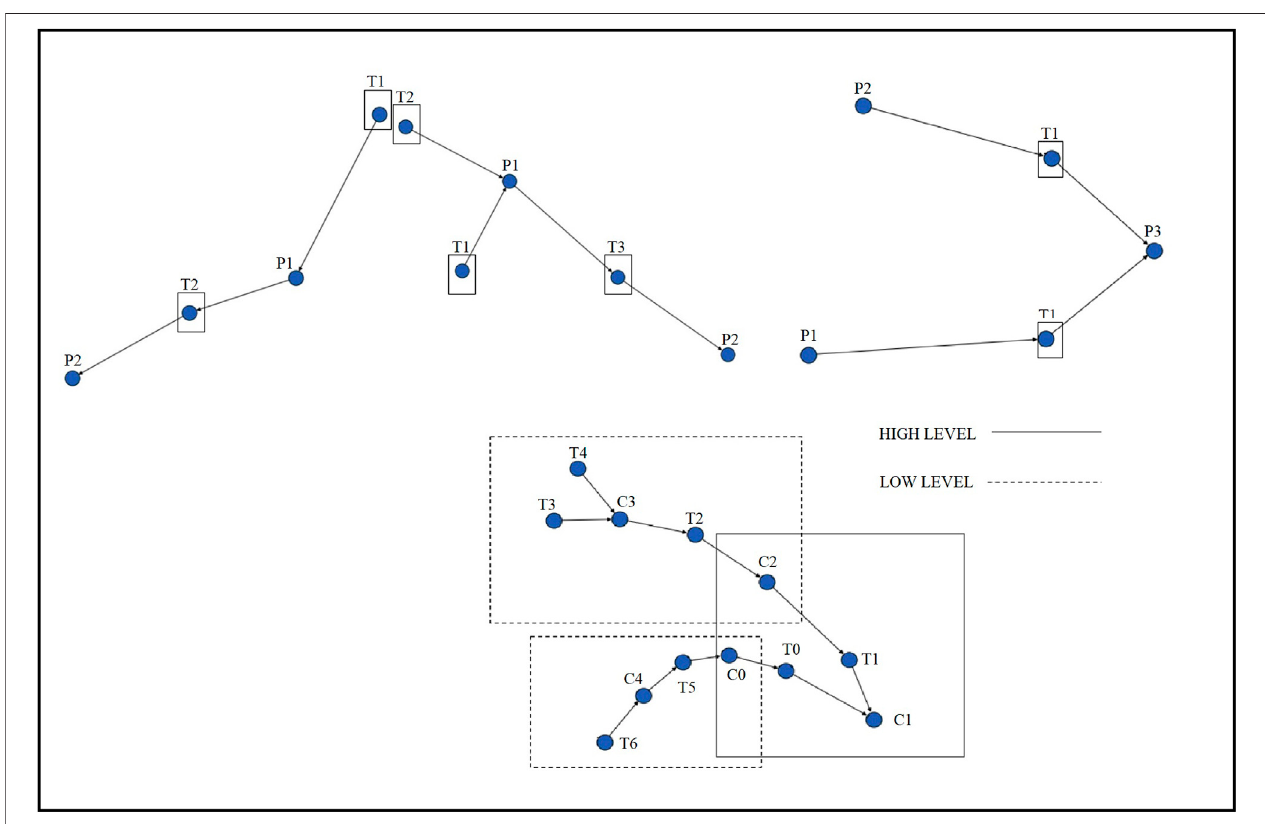
FIGURE 9 | Low, high and aggregated petri